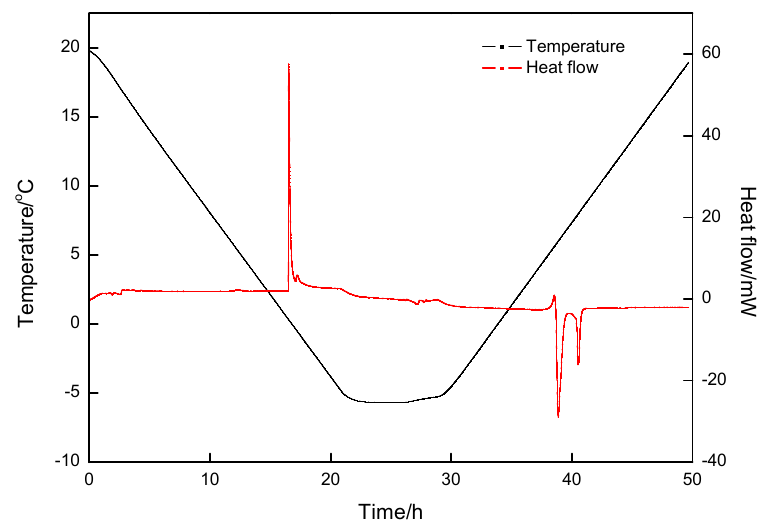
Figure 5. Heat flow and temperature curve at 20.0~ − 5.0 ◦ C and 5.0 MPa.